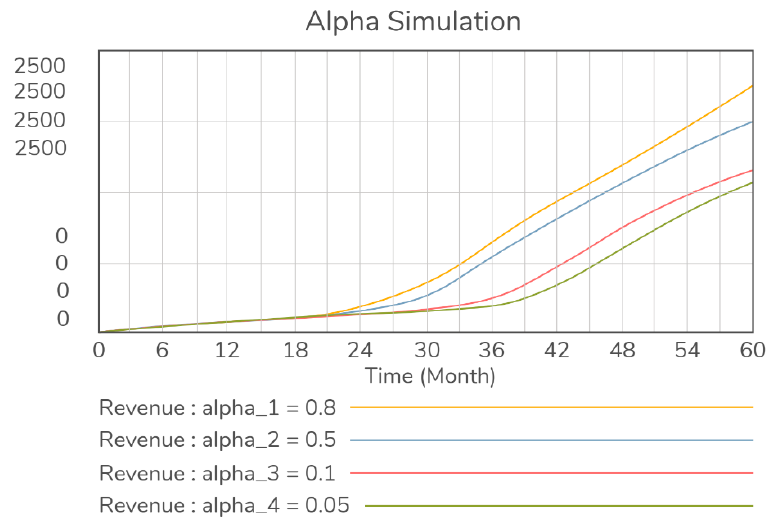
Figure 7. The OI simulation with four different alpha values related to Key Partners.